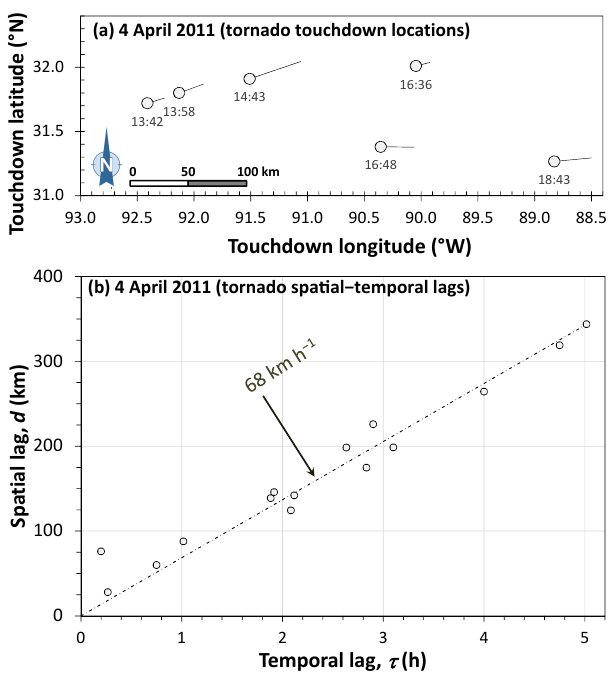
Figure 5. Tornado outbreak on 4 April 2011. (a) Touchdown locations of six severe ( L ≥ 10km) tornado that occurred on 4 April 2011 (convective day, 06:00CST–06:00CST) with touch- down times from 13:42 to 18:43CST. (b) The spatial lag d is plotted against the temporal lag τ for each of the 15 pairs of tornado touch- down points. The straight-line fit to the data passing through the origin gives a velocity v = 68.5kmh − 1